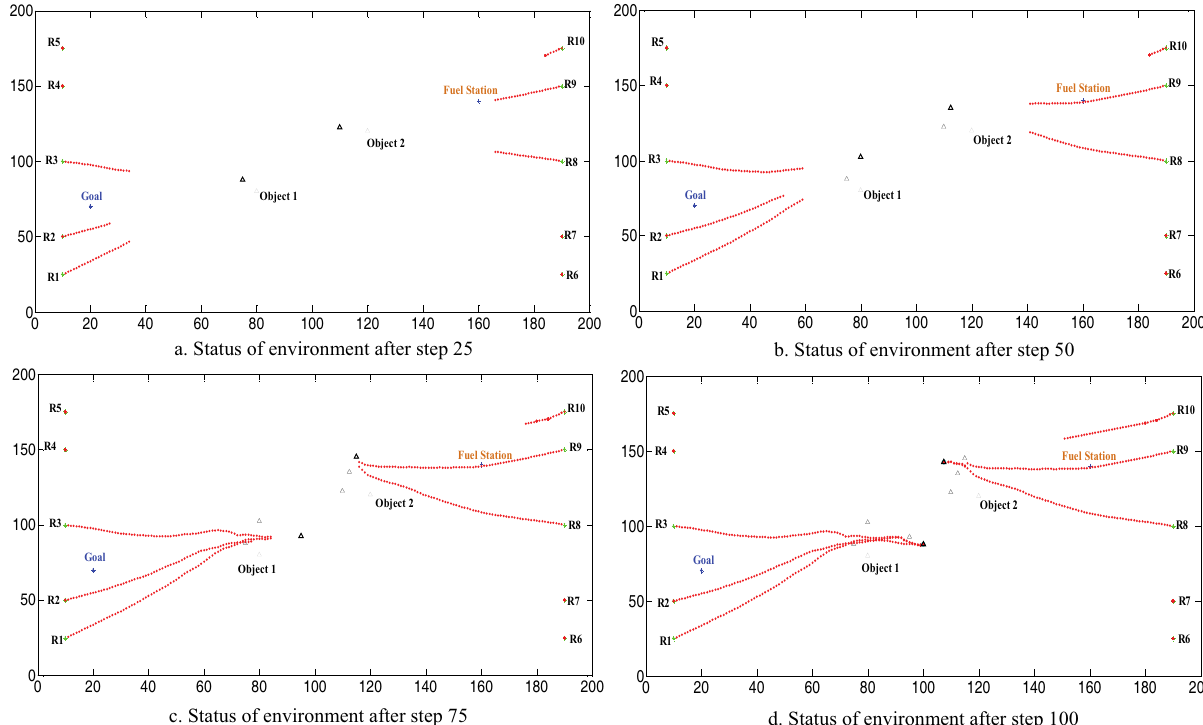
Fig. 10. Four snapshots of two-object foraging with random motion of the objects.